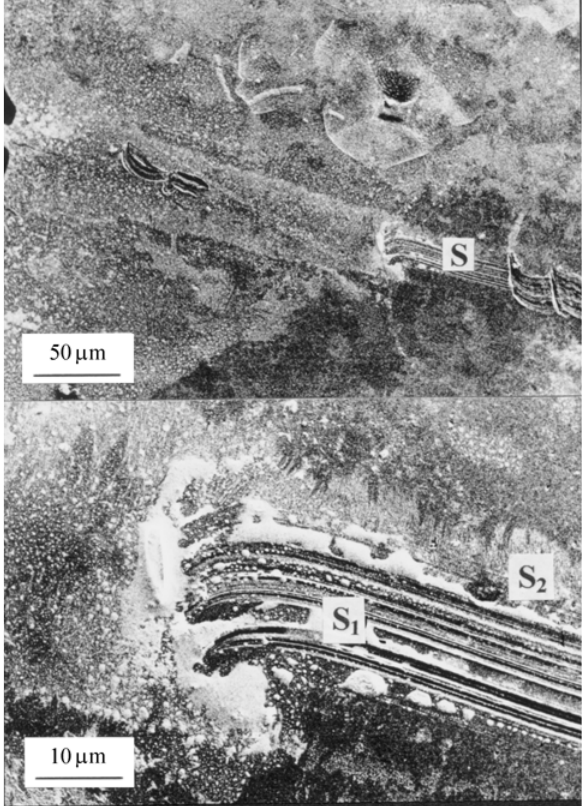
Figure 6. Lamellar resolution in well developed transcrystallization layer. Approximate sample locations for SEM observations marked T 1 , T 2 and S in (a), lamellar detail within transcrystalline layer at T 1 in (b), lamellar detail at the edge of transcrystalline layer at T 2 in (c). Original magnification 180X in (a), 15.000X in (b) and (c).